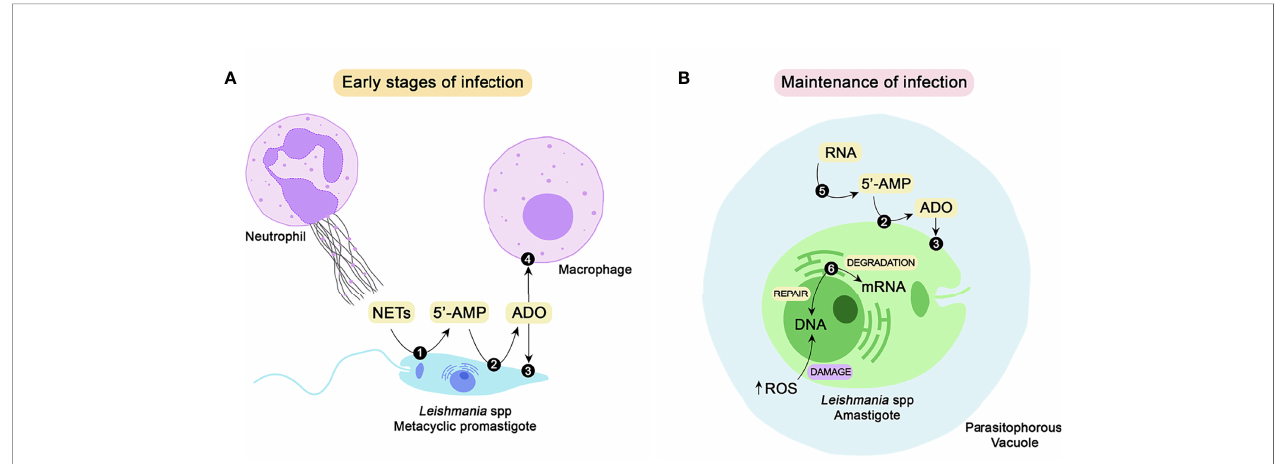
FIGURE 1 | Class I nucleases of Leishmania spp. and their possible roles during the establishment and maintenance of parasite infection. To successfully establish infection in the mammalian host, Leishmania promastigotes must impair the microbicidal repertoire of neutrophils and macrophages. One of the strategies for neutrophil-mediated killing is the release of NETs. The parasite can escape from the traps by DNA hydrolysis performed by 3 ’ -NT/NU (1), a membrane-bound class I nuclease. Hydrolysis of extracellular nucleic acids generates 5 ’ -monophosphorylated nucleotides, including 5 ’ -AMP, that can be converted to adenosine by the action of ecto 5 ’ -nucleotidase (2). Adenosine can be uptaken by parasites through nucleoside transporters (3) to supply the purine salvage pathway or bind to purinergic receptors (4) of host macrophages, thus favoring parasite infection (A) . To maintain the infective process, the parasites must differentiate into amastigotes, which can survive and proliferate inside parasitophorous vacuoles. Amastigotes express a secreted nuclease (5) that may mobilize extracellular nucleic acids located around the parasite and convert them to nucleotides, thus contributing to the purine salvage pathway. Another class I nuclease selectively expressed by amastigotes is P4/LmC1N nuclease (6). Located at the endoplasmic reticulum, this nuclease is probably involved in gene expression through mRNA degradation. Due to its endonuclease activity, this enzyme may also promote DNA repair, subverting the eventual damage caused by the oxidative burst (B) . NETs, neutrophil extracellular traps; 5 ’ -AMP, adenosine-5 ’ -monophosphate; ADO, adenosine; RNA, ribonucleic acid; DNA, deoxyribonucleic acid; ROS, reactive oxygen